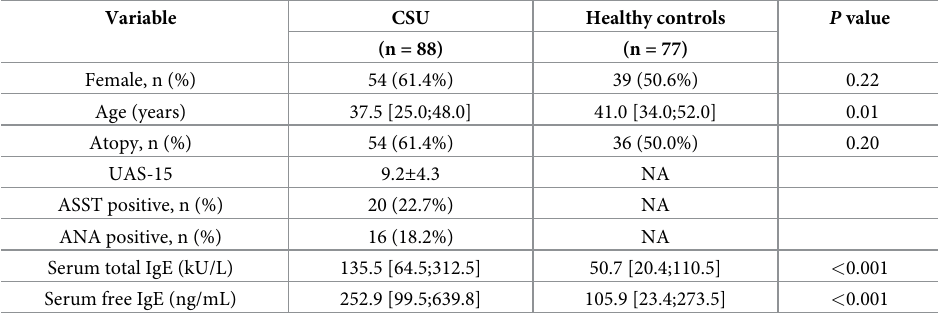
Table 1. Clinical characteristics of the study subjects in the cohort. Variable CSU Healthy controls P value (n = 88) (n = 77) Female, n (%) 54 (61.4%) 39 (50.6%) 0.22 Age (years) 37.5 [25.0;48.0] 41.0 [34.0;52.0] 0.01 Atopy, n (%) 54 (61.4%) 36 (50.0%) 0.20 UAS-15 9.2 ± 4.3 NA ASST positive, n (%) 20 (22.7%) NA ANA positive, n (%) 16 (18.2%) NA Serum total IgE (kU/L) 135.5 [64.5;312.5] 50.7 [20.4;110.5] < 0.001 Serum free IgE (ng/mL) 252.9 [99.5;639.8] 105.9 [23.4;273.5] < 0.001 Non-parametric values are presented as median [IQR] and parametric values or mean ± SD. Categorical values are shown as number (percentage). P values were evaluated by the t test or the Mann-Whitney test. CSU, chronic spontaneous urticaria; HCs, healthy controls; UAS, urticaria activity score; ASST, autologous serum skin test; ANA, antinuclear antibody, NA: not available